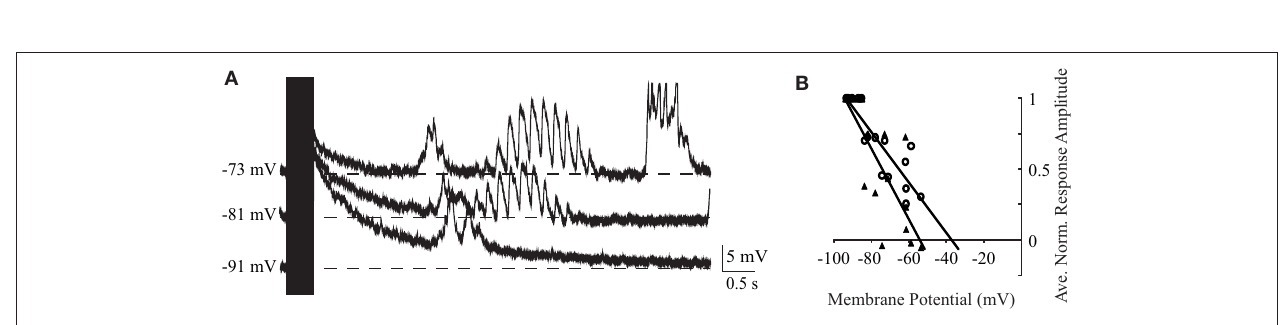
FIgure 6 | Voltage dependence of summation of excitation and inhibition. (A) Representative PSP elicited in the same GC neuron by trains of five BLA shocks at 40 Hz at different holding potentials. (B) Population plot of response amplitudes to 40 Hz stimulation at different membrane potentials. Reponses at − 69.5 mV are dominated by the summation of inhibition while stimulation at more hyperpolarized potentials results in a sustained depolarization. x -axis: stimulus number, y -axis: normalized response amplitude from pre-train baseline